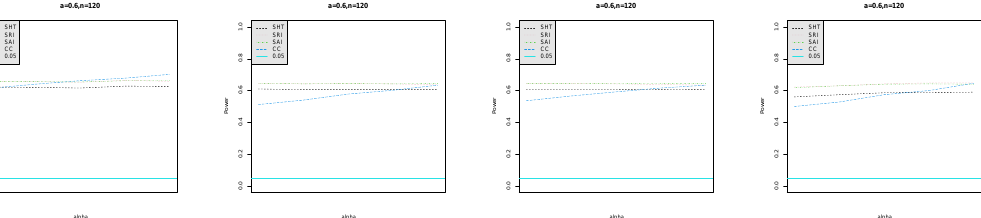
Figure A5. SHT, SRI, SAI and CC represent empirical powers evaluated from IPW, regression imputation, AIPW and CC methods against treatment effect α E 1 for missingness data mechanism models E1 (left panel), E2 (left second panel), E3 (right second panel) and E4 (right panel) for ( a , n ) = (0.2,80) (the first row), (0.2,120) (the second row), (0.6,80) (the third row) and (0.6,120) (the last row) under the balanced designs.